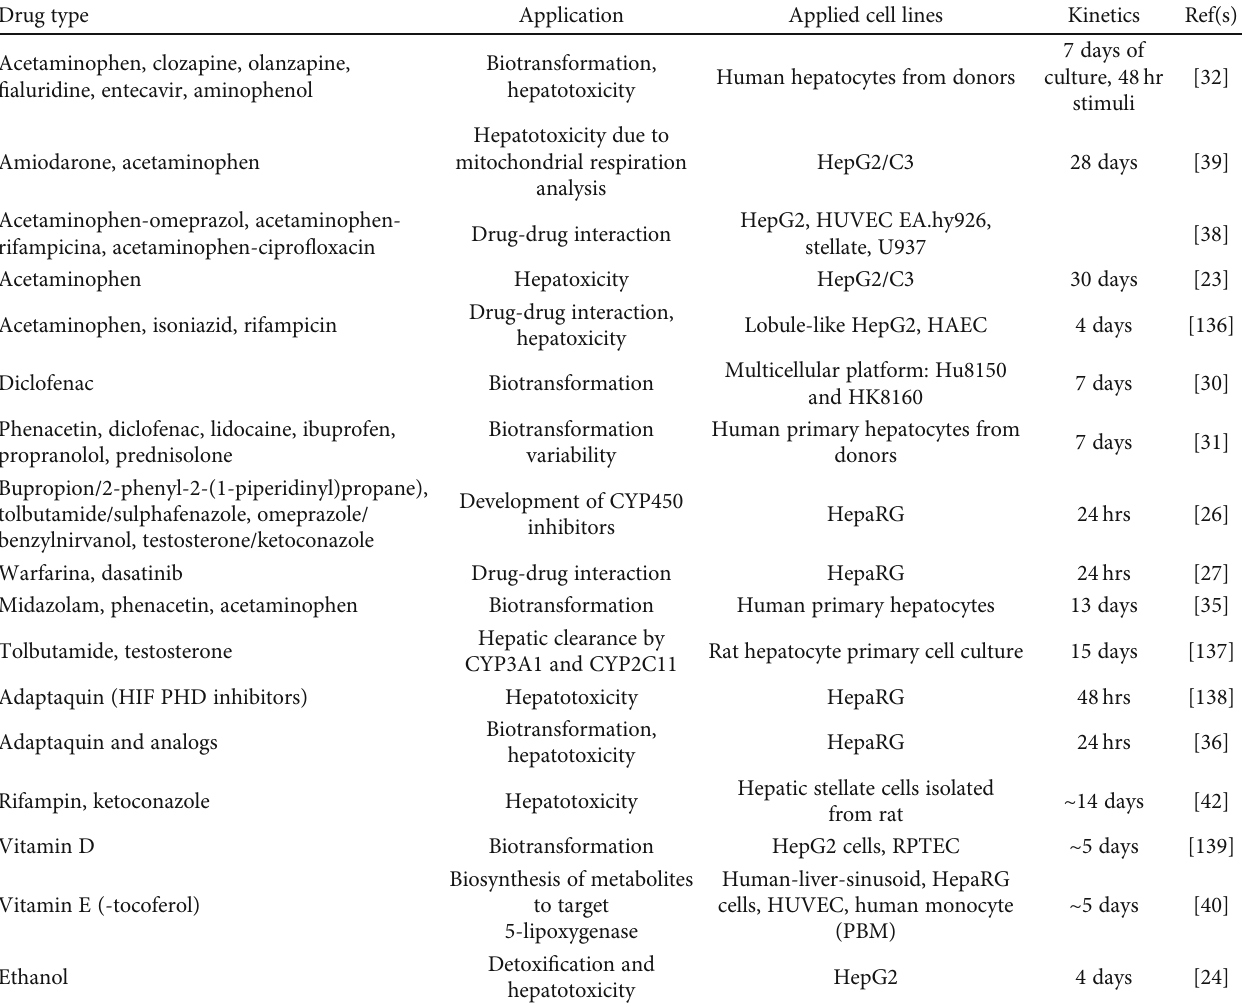
Table 1: Summary of recent advancements hepatotoxicity testing including the type of drug, the application, the applied cell lines, and the